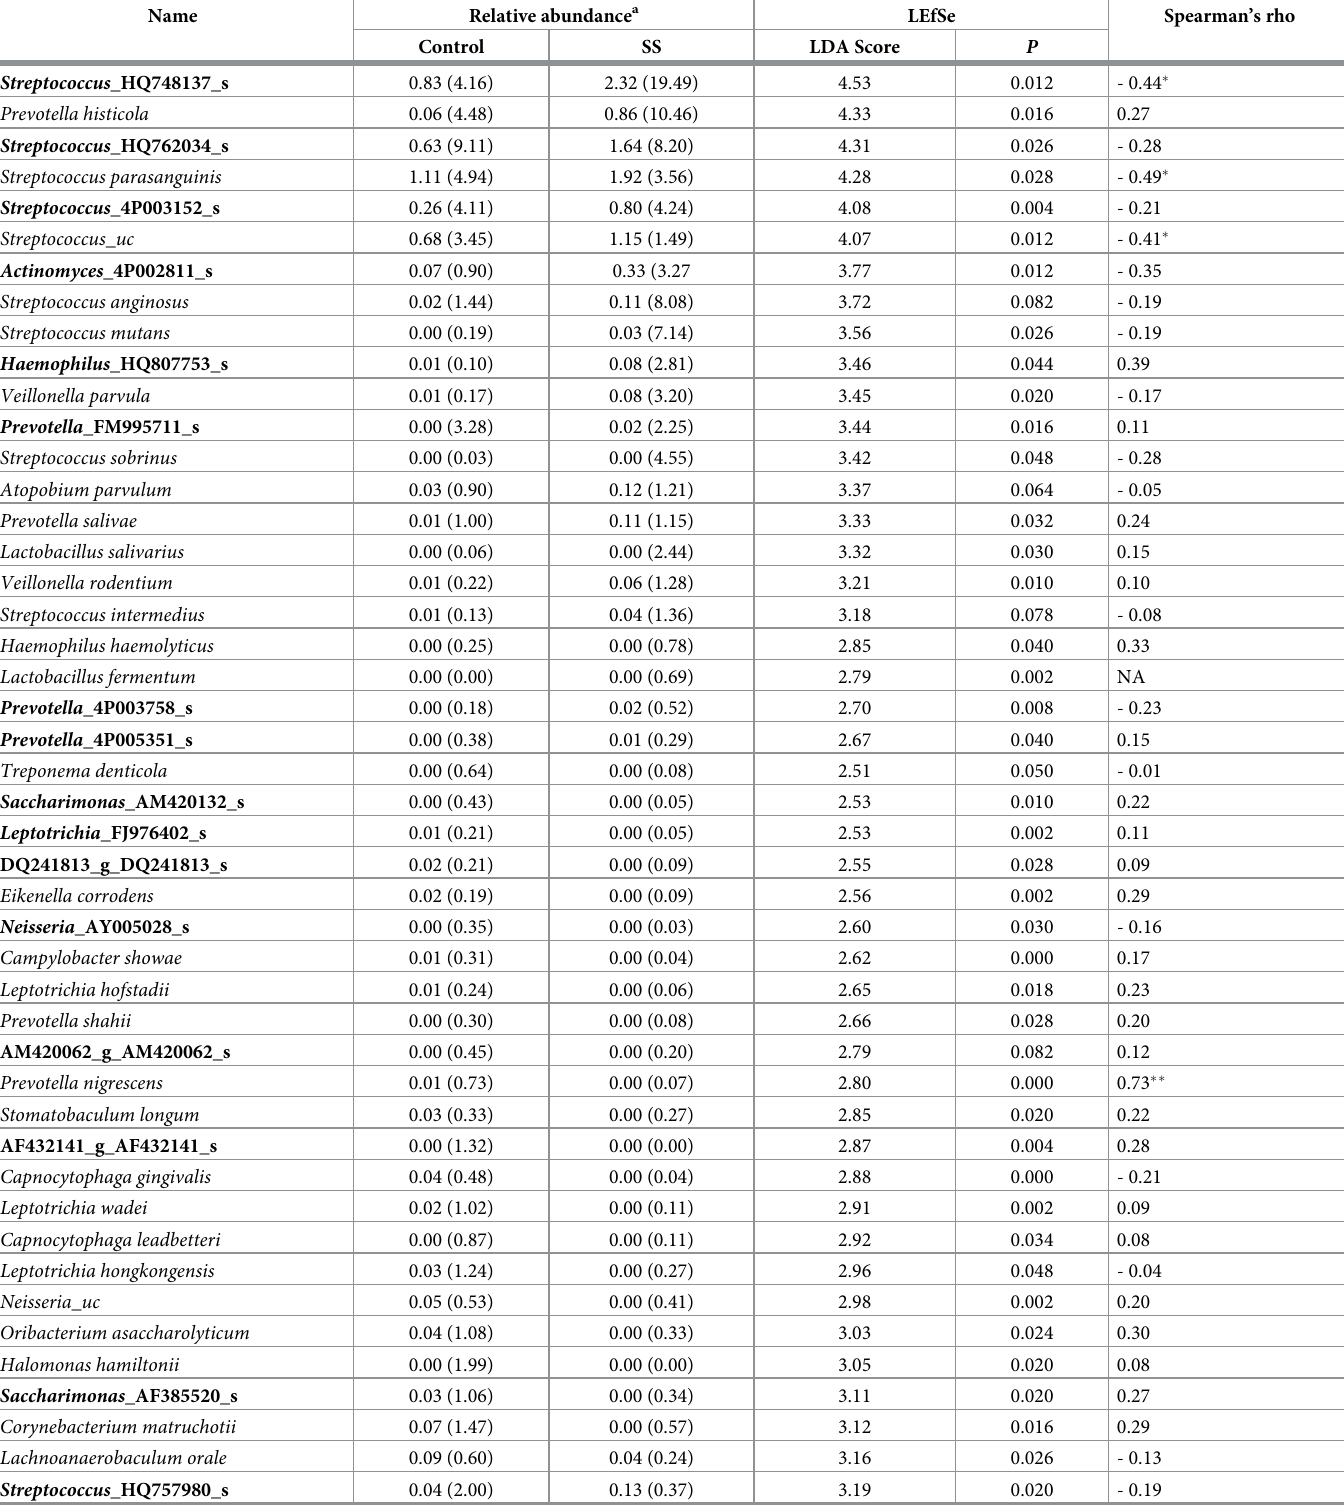
Table 2. Species associated with control (n = 25) vs. SS (n =